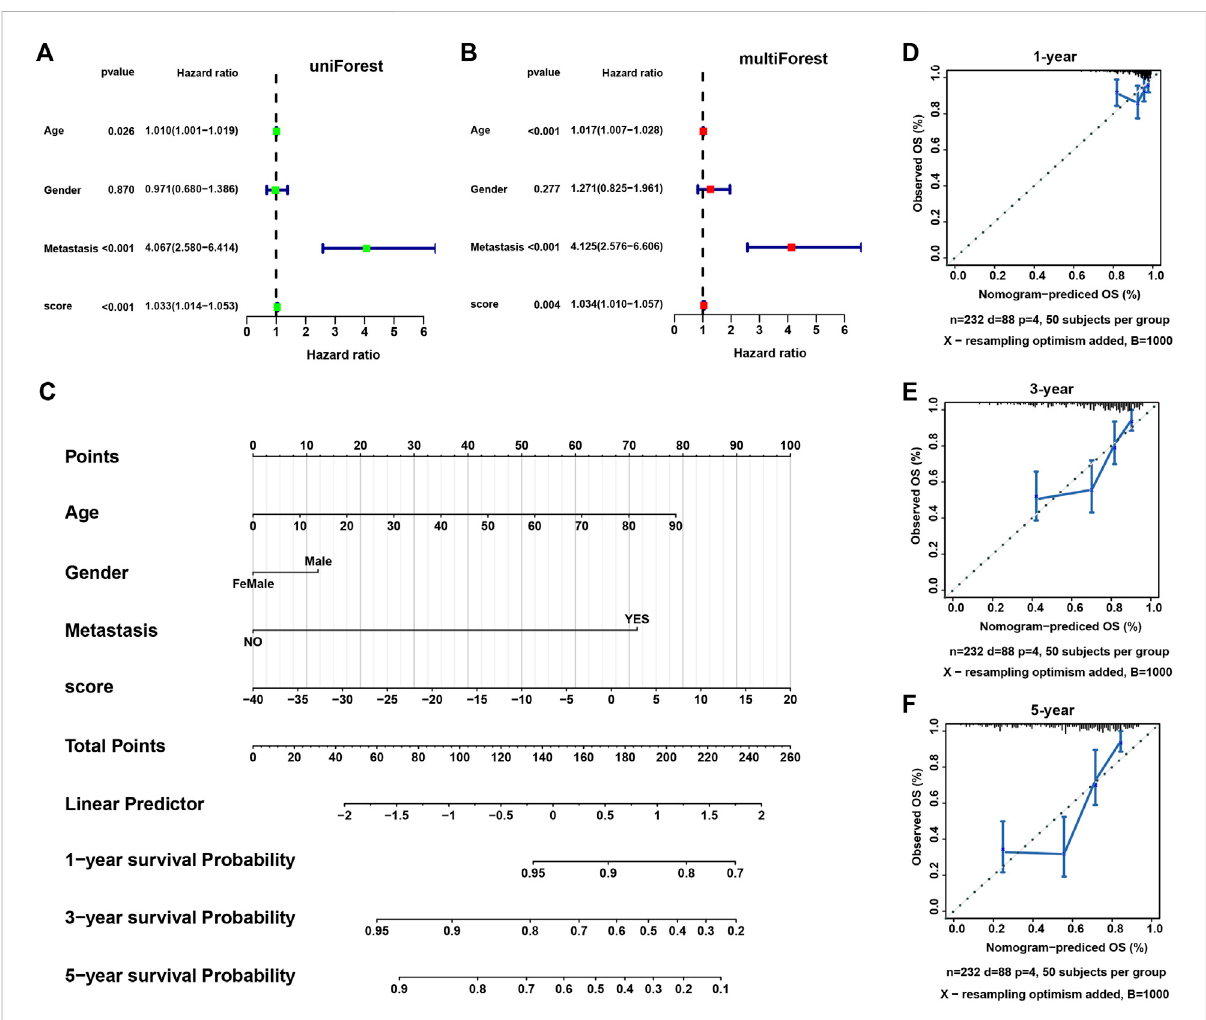
FIGURE 8 The construction of a nomogram model. (A,B) The univariate and multivariate Cox regression analysis of necroptosis score and other clinical features. (C) A nomogram based on necroptosis score and clinical features for predicting 1-, 3-, and 5-year survival. (D – F) The calibration plots showing the performance of the nomogram of predicting 1-, 3-, and 5-year overall